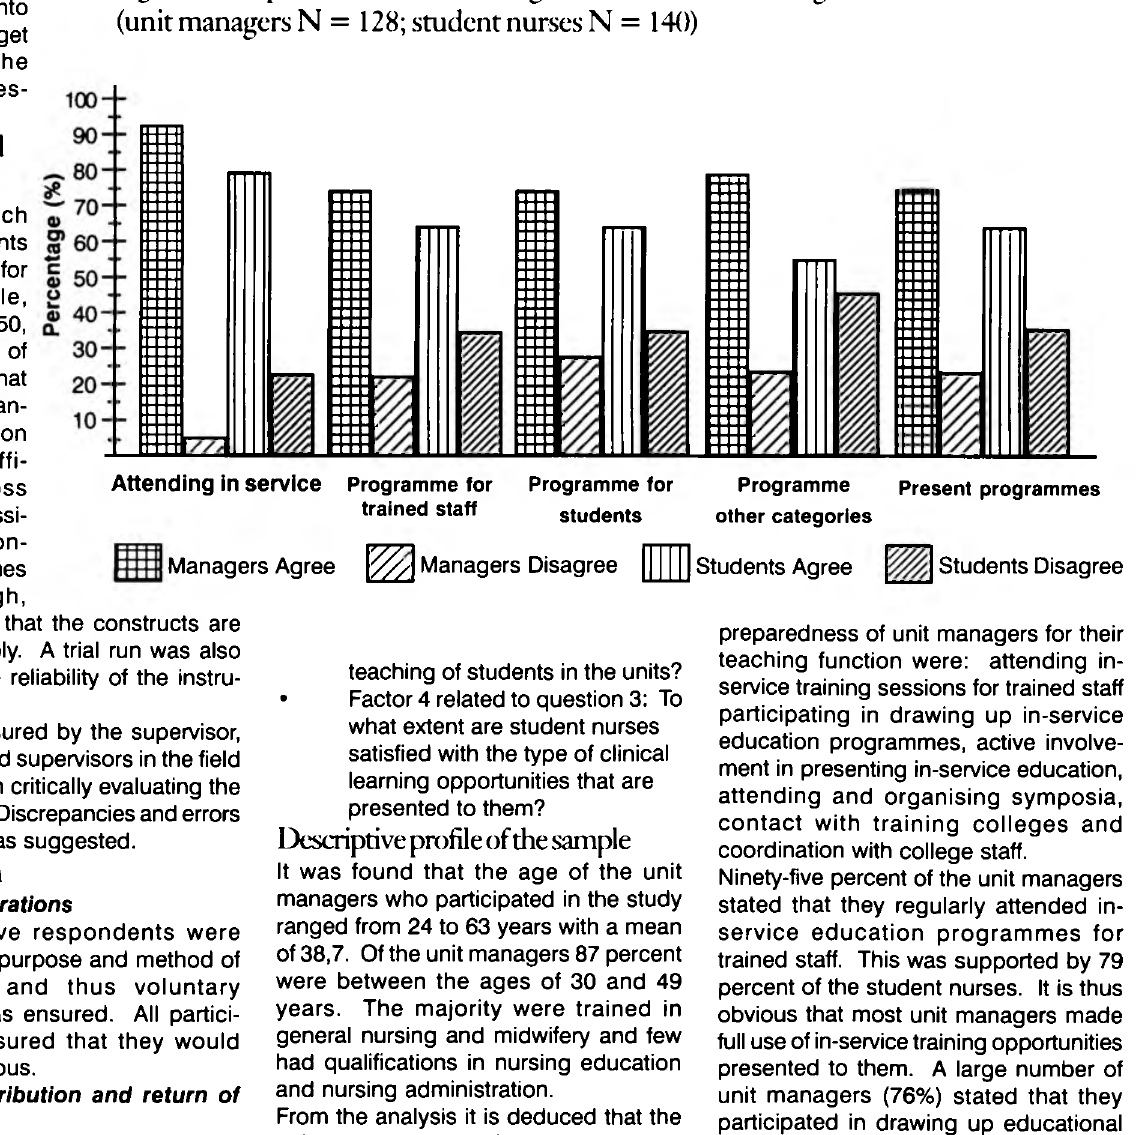
Figure 1: Preparedness of unit managers for in-service training (unit managers N = 128; student nurses N = 140)